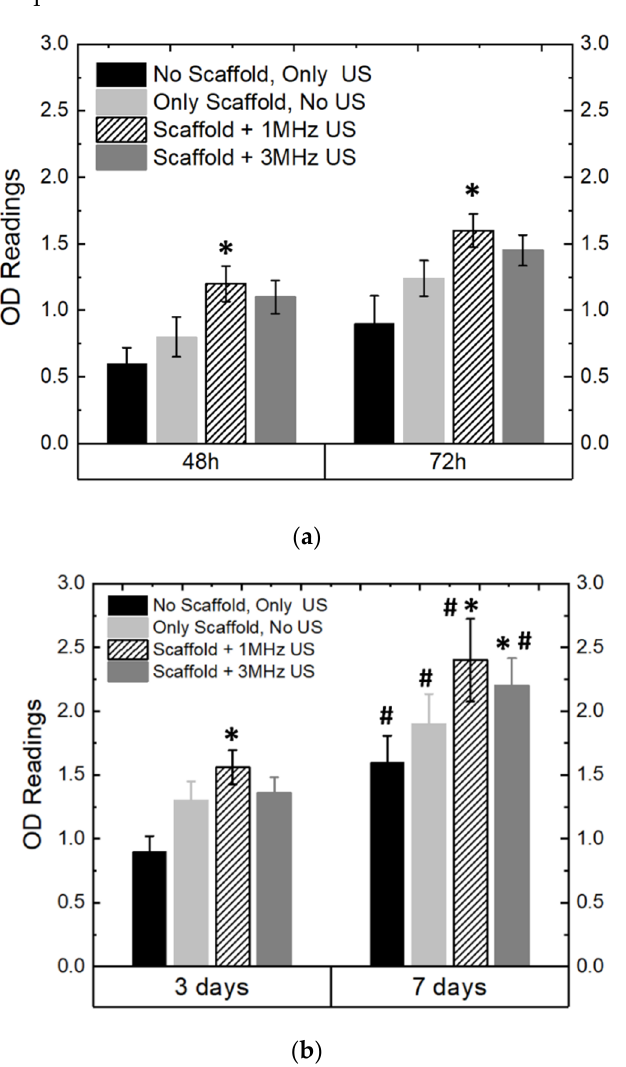
Figure 10. Ultrasonic stimulation (US) and in vitro properties of the scaffolds. OD readings of MC3T3 cells as cultured on the piezoelectric scaffolds (PCL-65BT) with respect to different intensities of US over ( a ) 72 h and ( b ) 7 days. * means statistically significant ( p < 0.05) with respect to “no scaffold, only US”. # means statistically significant ( p < 0.05) with respect to the specimens in the “3 days”